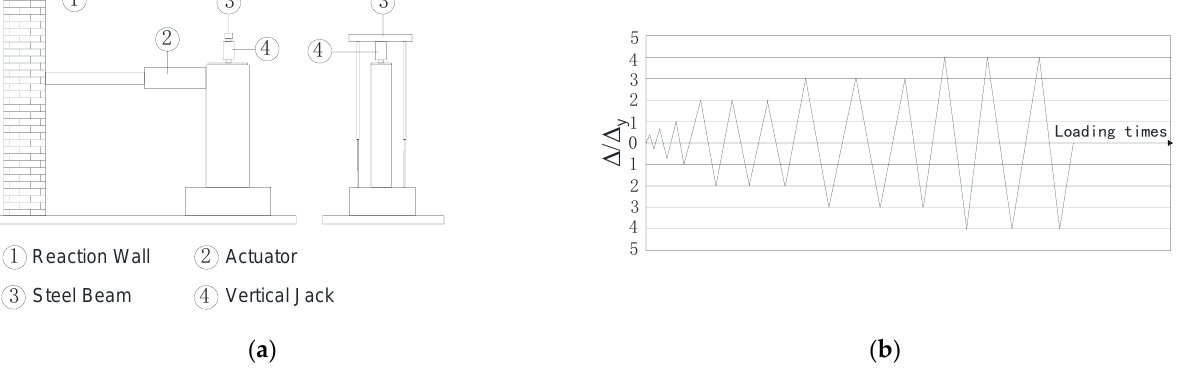
Figure 5. The Test Setup. ( a ) The schematic diagram. ( b ) The loading protocol.